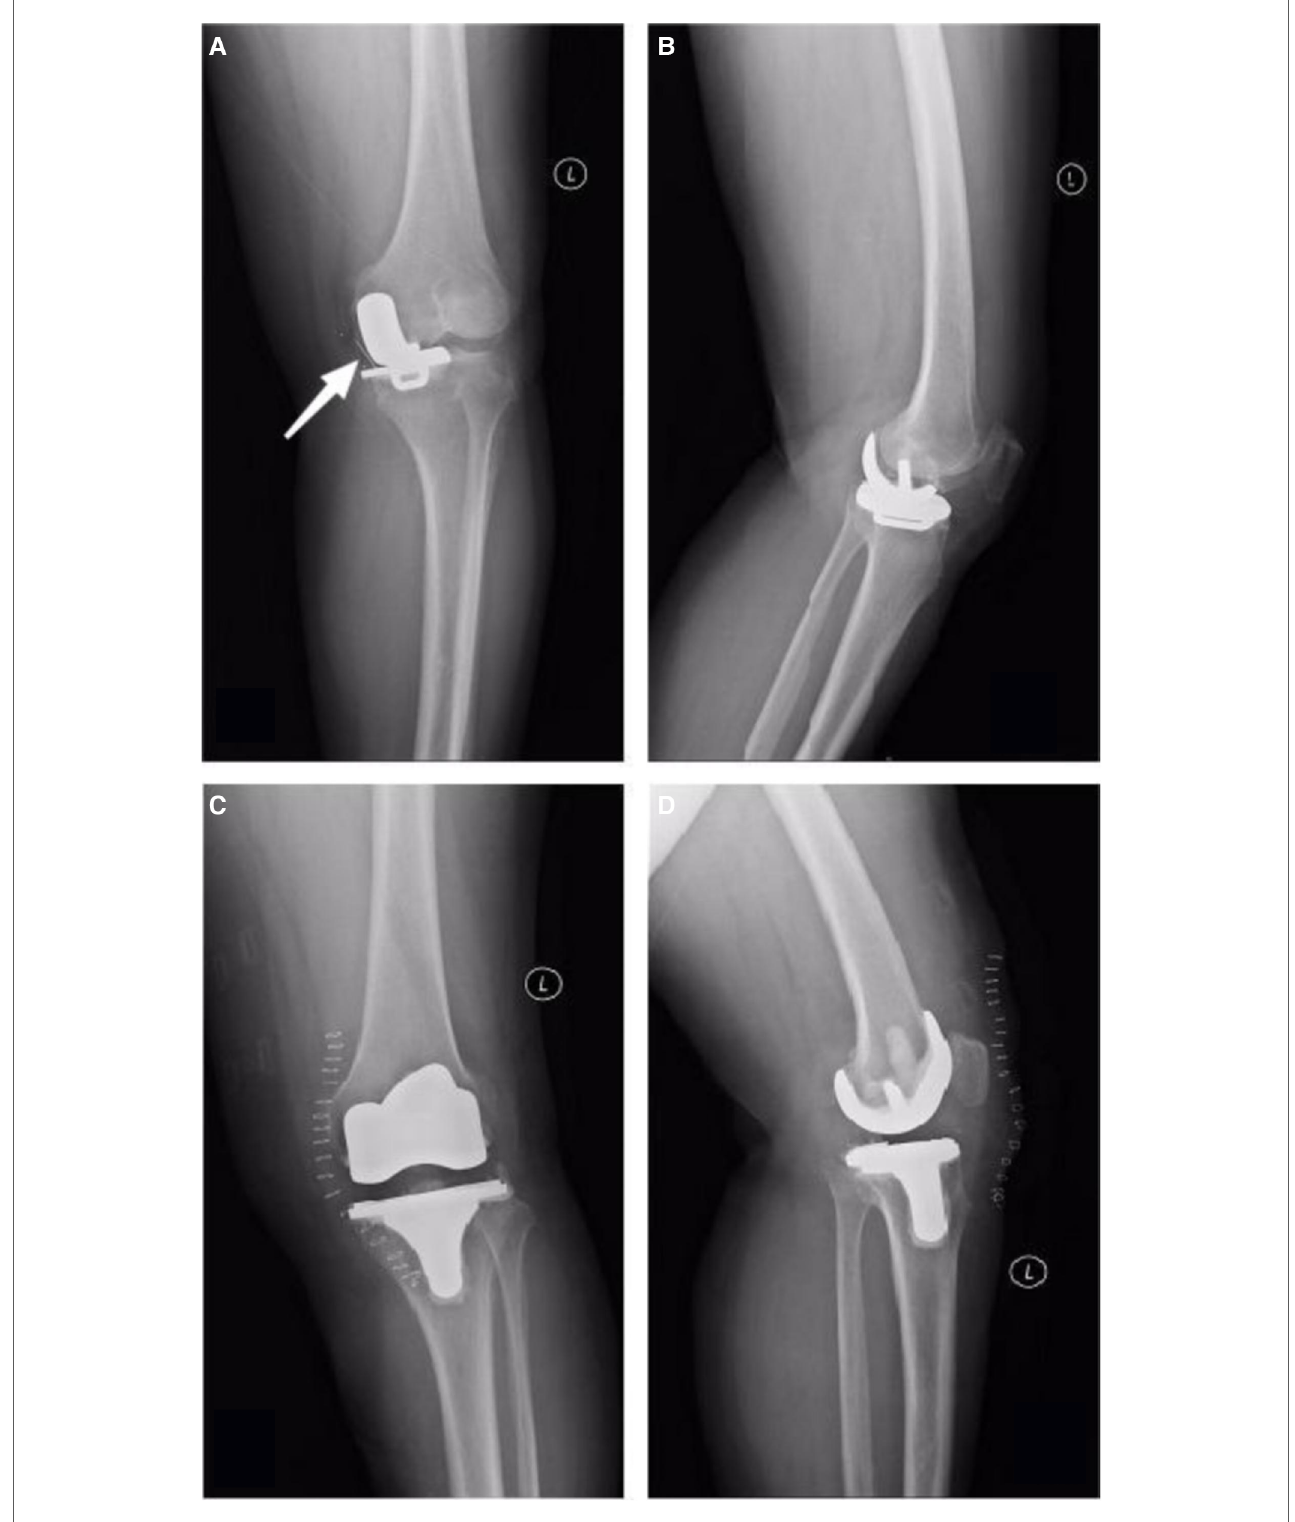
FIGURE 4 X-rays 5 months after UKA of the left knee and 3 days after conversion to TKA in a 65-year-old woman, White arrow: Poly backed out ( A ) Anteroposterior position of left knee joint 5 months after UKA, Poly backed out. ( B ) Lateral position of left knee joint 5 months after UKA. ( C ) The prosthesis of left knee joint was removed, and the surgical method was changed to TKA, anteroposterior position of left knee joint 3 days after TKA. ( D ) Lateral position of left knee joint 3 days after